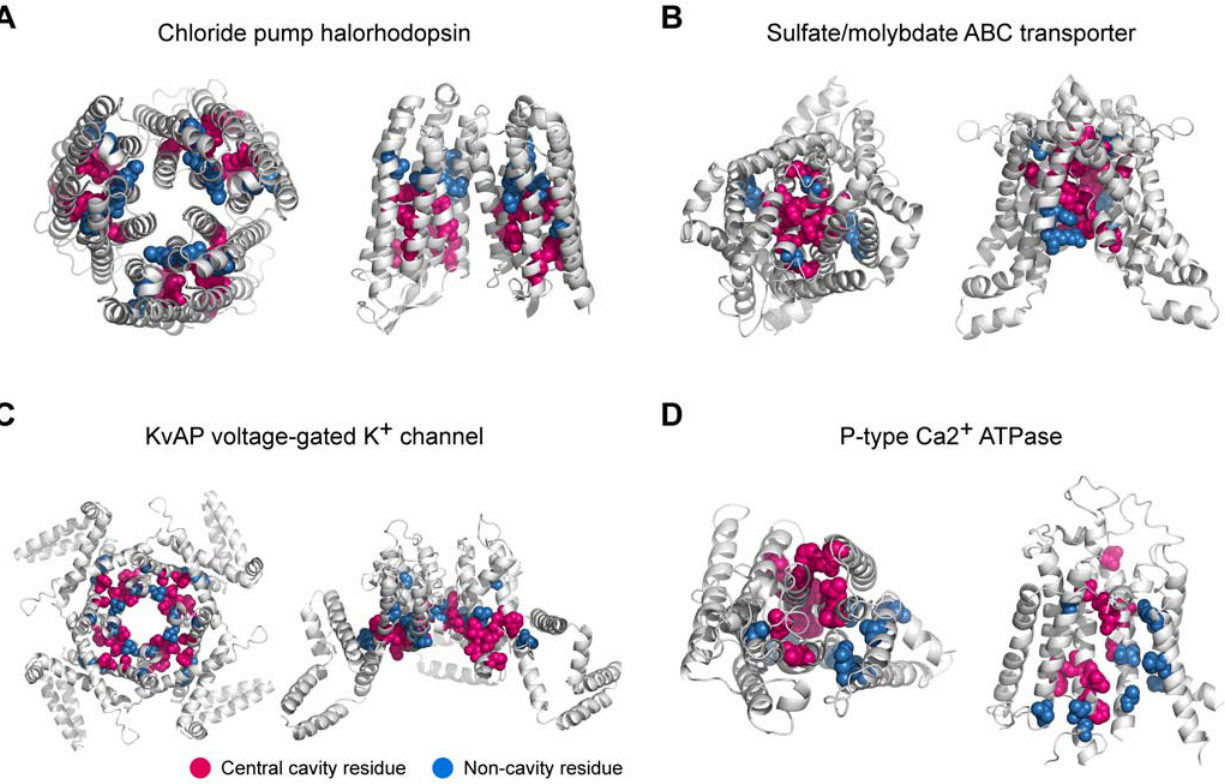
Figure 6. High-IS residues of other membrane protein transporters. Positions of the detected residues are highlighted. Cavity residues are colored red and non-cavity residues are colored blue. The top view (left) and the side view (right) of membrane protein transporters are shown. (A) Chloride pump halorhodopsin (PDB ID: 1E12), (B) Sulfate/molybdate ABC transporter (PDB ID: 3D31), (C) KvAP voltage-gated K + channel (PDB ID: 1ORQ), and (D) P-type Ca2 + ATPase (PDB ID: 1WPG).